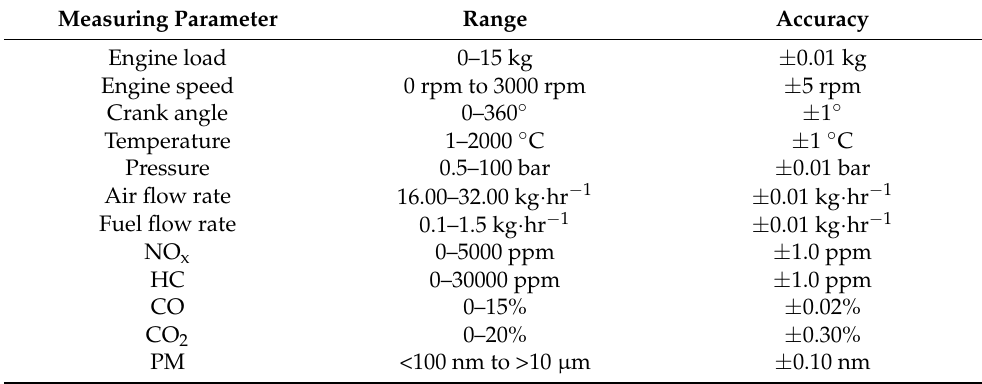
Table 3. Errors and uncertainties in the measurements created by different